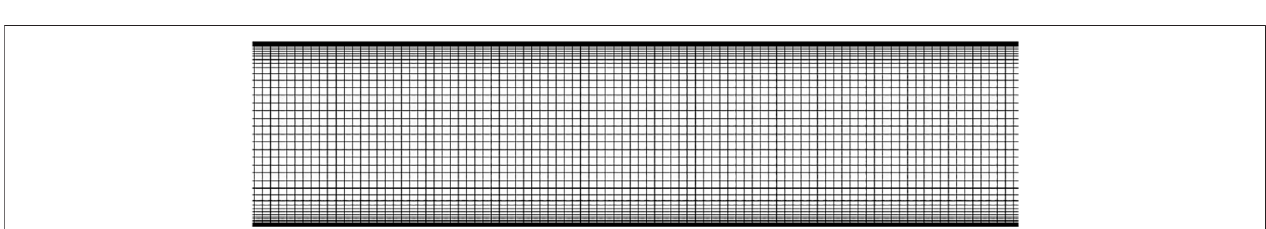
FIGURE 2 | Grids of the smooth fracture.